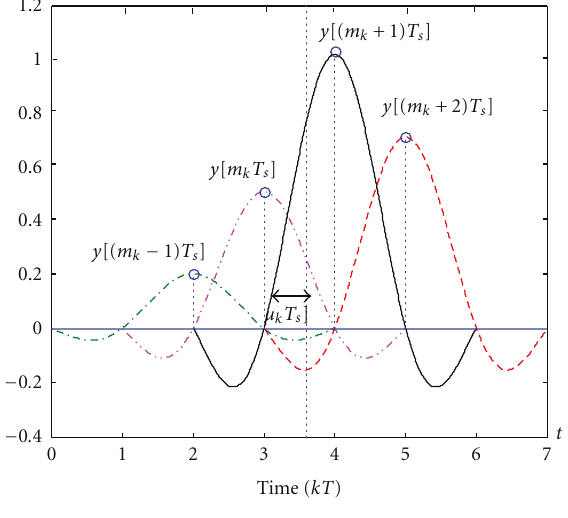
Figure 2: Resample y ( kT ).